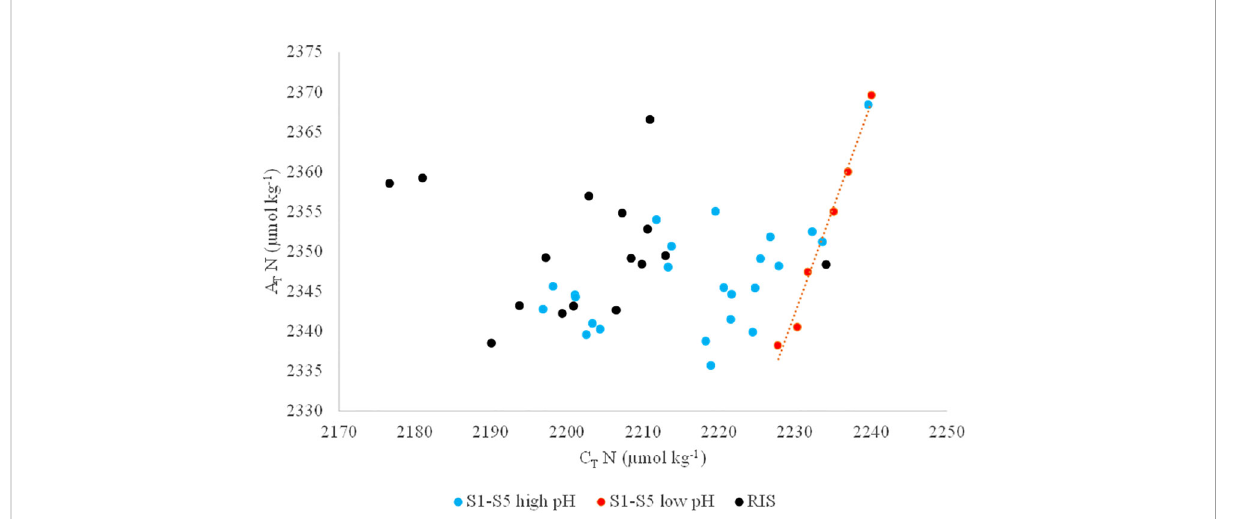
FIGURE 6 Normalized total alkalinity (A T N) as a function of normalized total inorganic carbon (C T N). Black dots (RIS) refer to samples taken along the RIS, blue dots (S1-S5 high pH) refer to samples taken in sections S1-S5 having a pH higher than 8.05 and pCO 2 lower than 398 µatm and red dots (S1-S5 low pH) refer to samples taken in sections S1-S5 having a pH lower than 8.05 and pCO 2 higher than 398